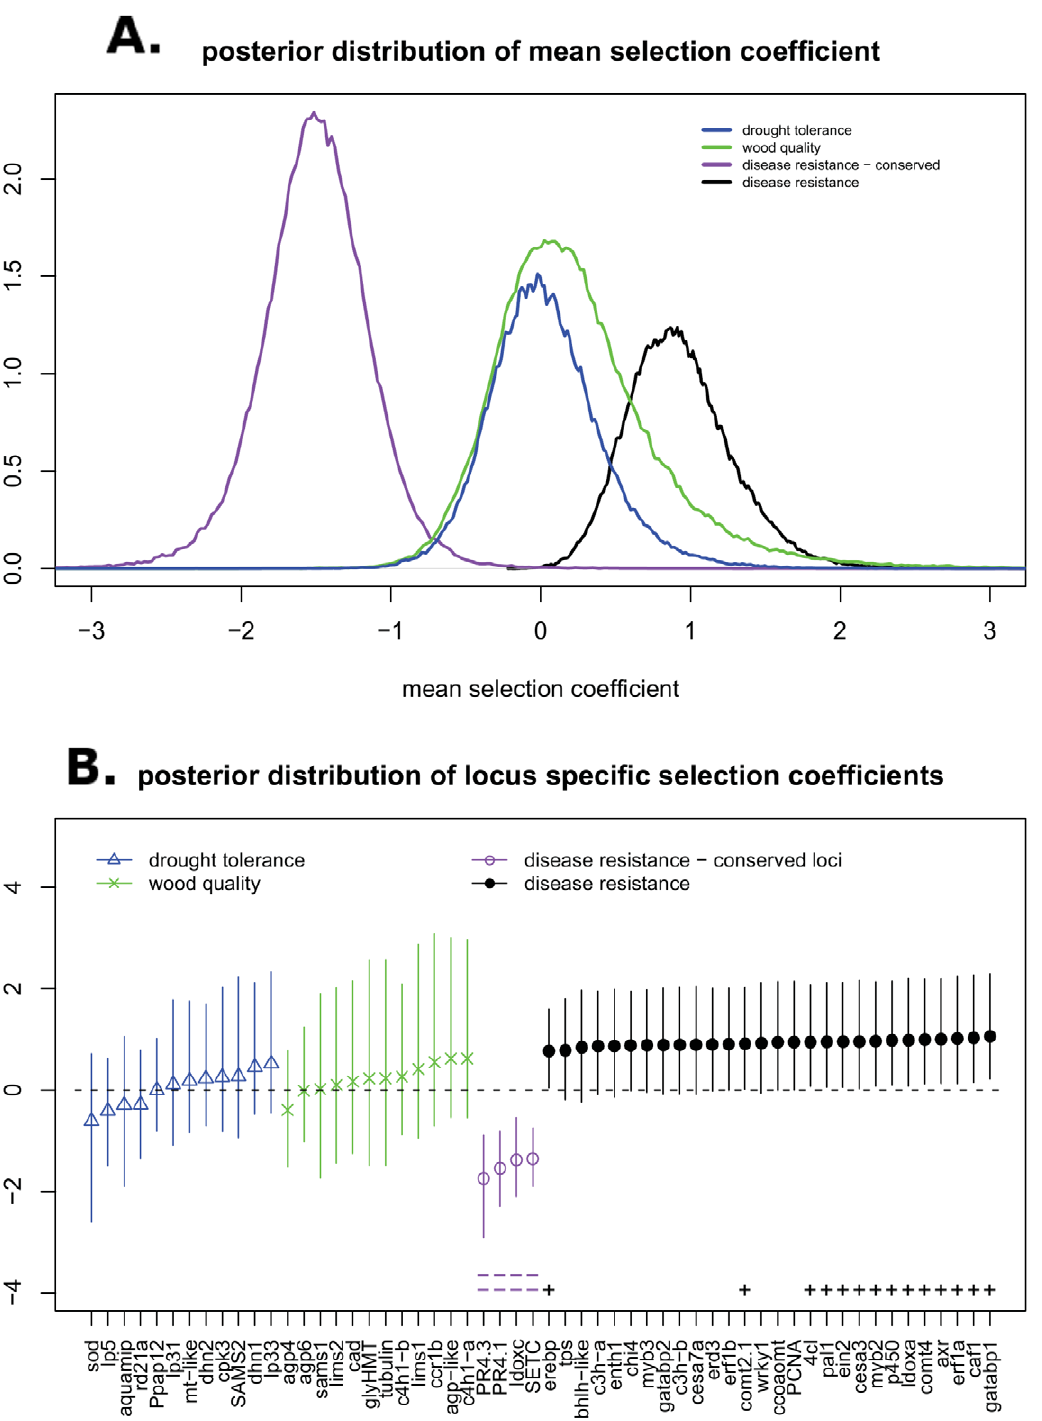
Figure 2. MKPRF analysis showing the posterior distribution of the mean selection coefficient across groups of loci (panel A), and the mean and 95% credible interval of the posterior distributions for per-locus selection coefficients (panel B). A selection coefficient less than zero implies selective constraint at amino acid replacement sites while a coefficient greater than zero implies accelerated fixation of amino acid replacements.